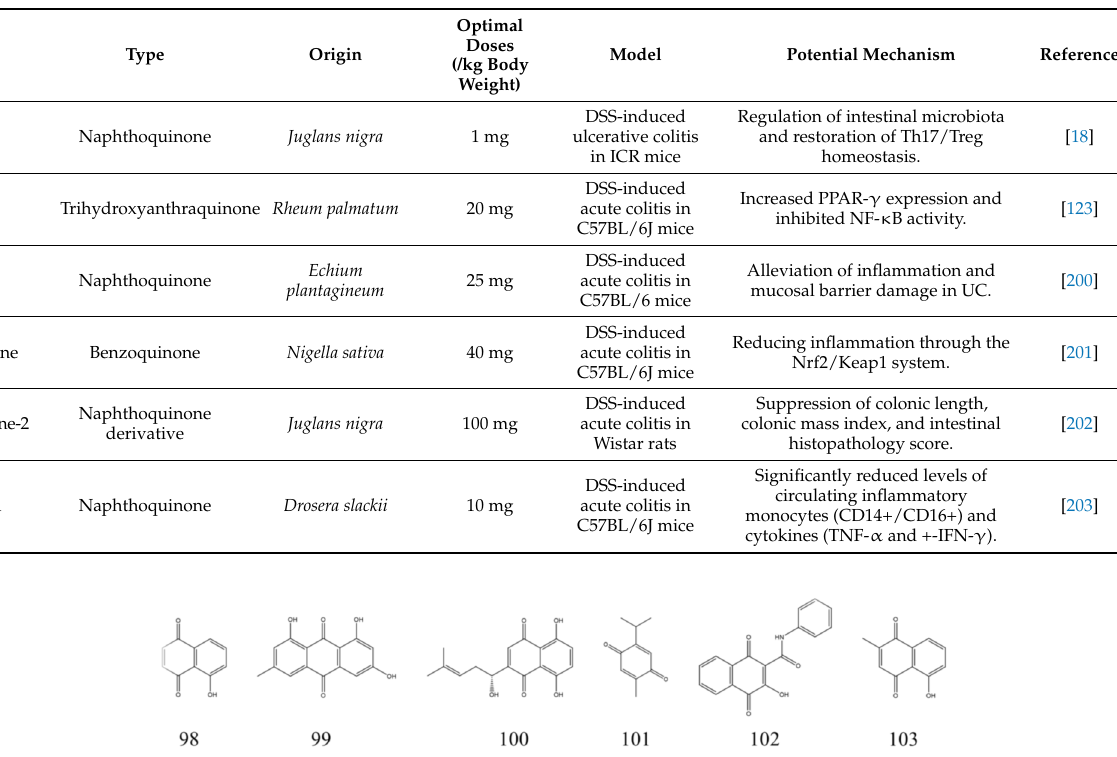
Table 5. In vivo therapeutic effects of quinones on experimental IBD.